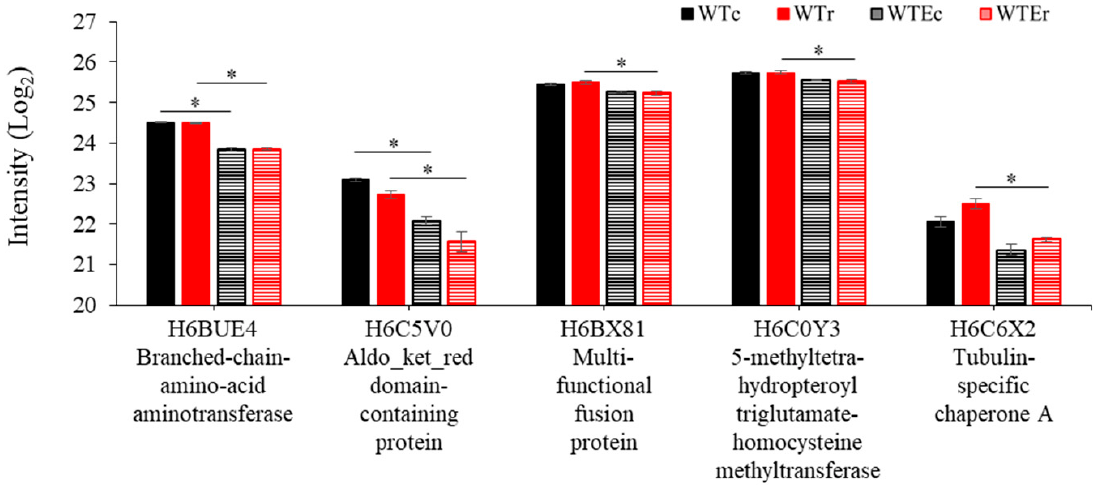
Figure 4. Intensity levels of proteins decreased in the Evolved strains, in comparison with WT strains. Note that only a portion of the Y axis is shown to highlight the small, but significant, differences in intensity levels. Error bars represent standard error. Asterisks indicate instances of statistically significant comparisons.